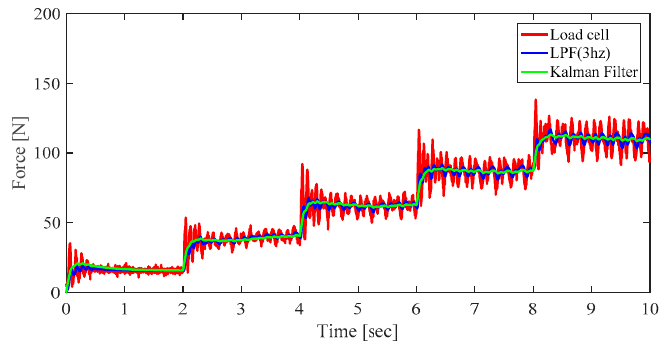
Figure 4. Results of signal processing.